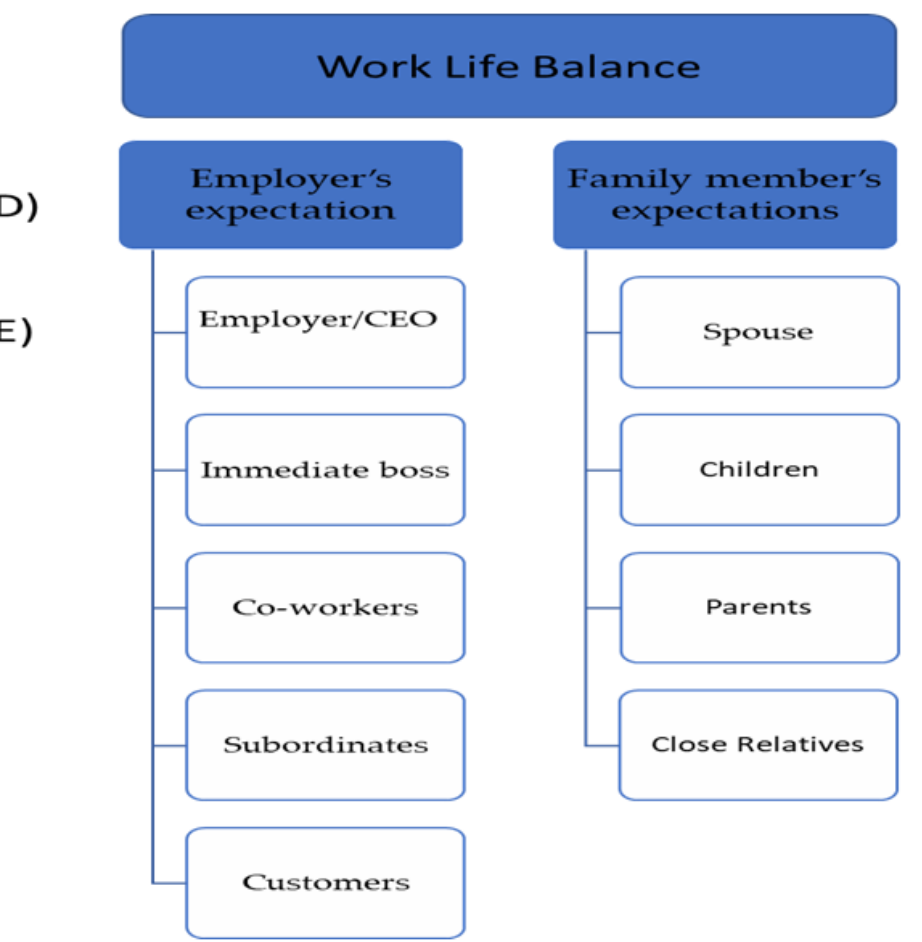
Figure 2. Dimensions and elements of the construct of work-life balance. Source: authors ’ own pro- cessing.